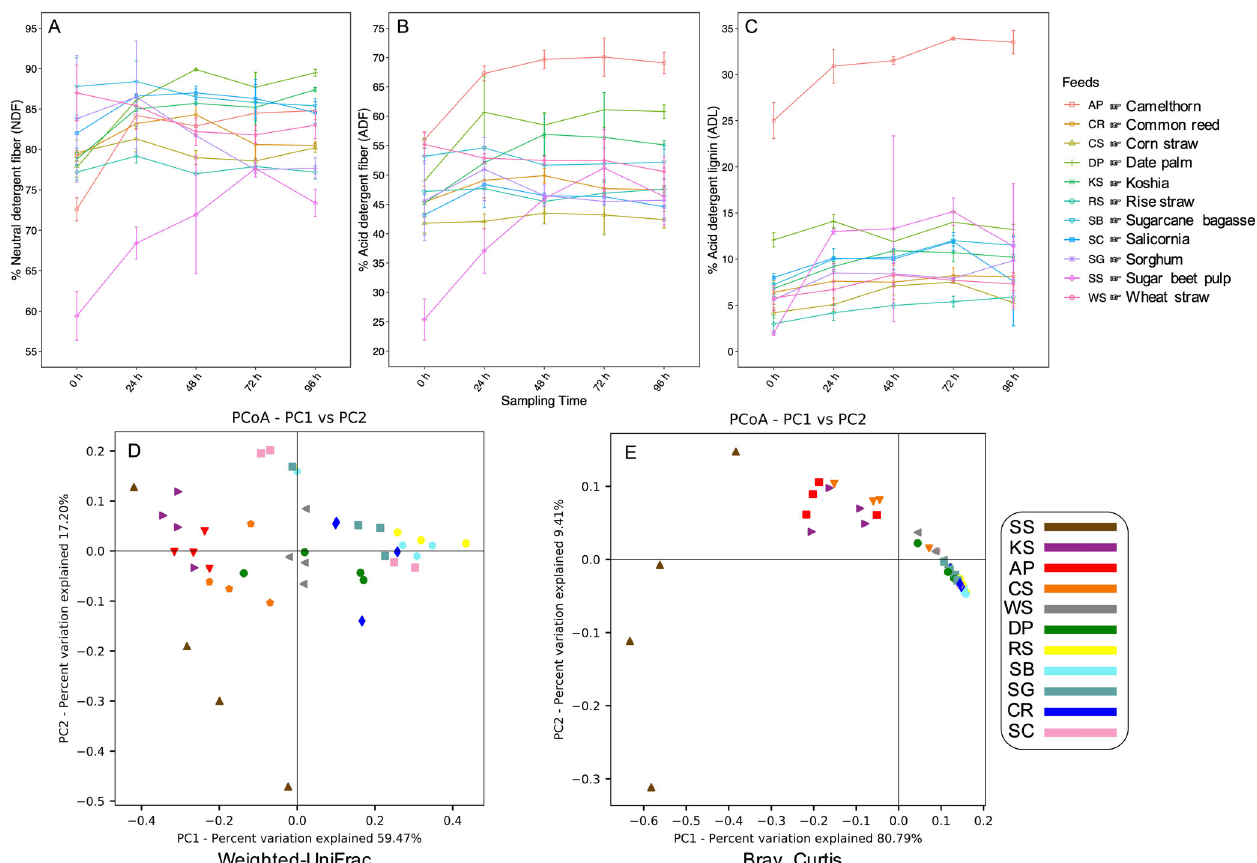
Fig. 1 Forage physicochemical properties and the diversity of their attached microbiota during incubation in the camel rumen. Forages degradability was evaluated by measuring ( A ) neutral detergent fi ber (NDF), ( B ) acid detergent fi ber (ADF) and ( C ) acid detergent lignin (ADL) concentrations during incubation in the rumen. Concentrations are presented based on percentage of dry matter. Data points are mean and error bars represent standard errors. Beta diversity of camel rumen microbiota attached to the forages was explored by searching reads against ~1.1 M lineage-speci fi c marker genes using MetaPhlAn 83 . Principal coordinate analysis (PCoA) plot shows community diversity of rumen microbiota attached to 11 different forages incubated in the camel rumen based on ( D ) weighted UniFrac and ( E ) Bray_Curtis dissimilarity matrices. Samples are grouped based on feeds and each feed is represented by a unique shape and